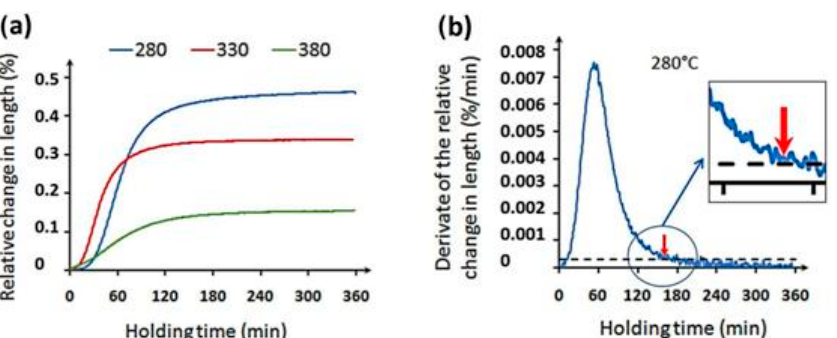
Figure 6. ( a ) Relative change in length function of time of isothermal heat treatments at 280, 330, and 380 ◦ C. ( b ) Determination of time to end the transformation at 280 ◦ C by means of the DRCL (horizontal line corresponds to 4% of the maximum DRCL and the arrow pinpointed the determined